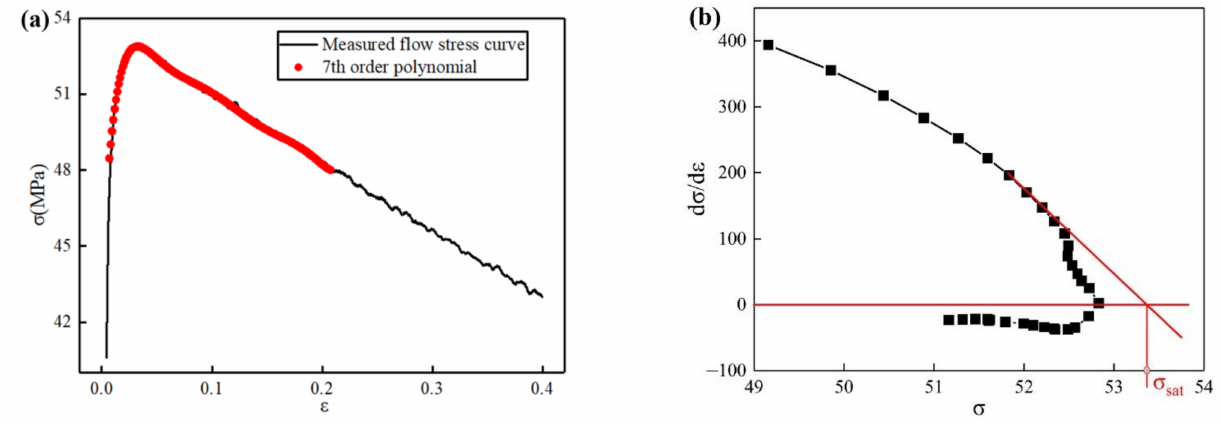
Figure 4. The relation curves between ln [ sinh ( ασ )] , ln . ln [ sinh ( ασ )] and ln ε ; ( b ) the relation between ln [ sinh ( ασ )] and 1/ T .